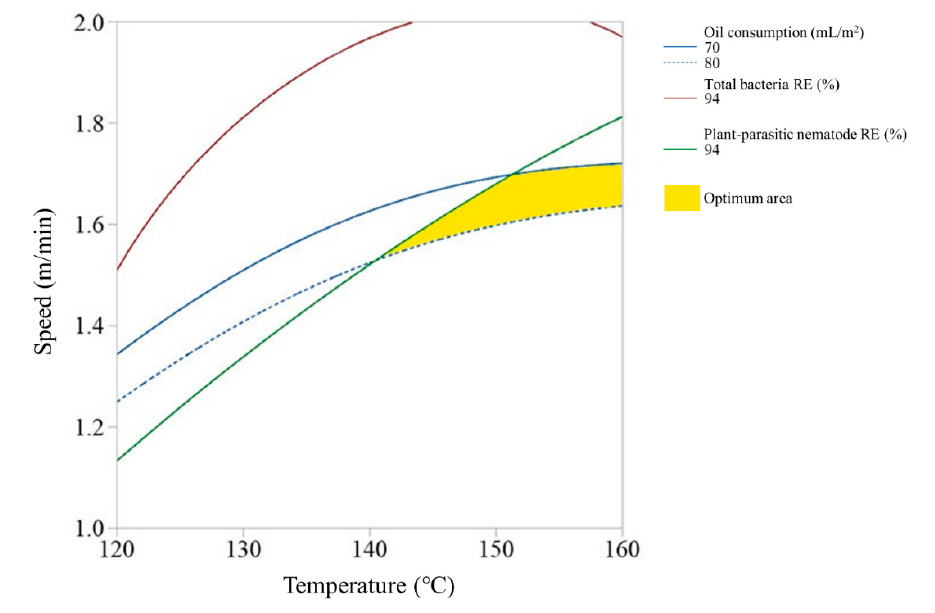
Figure 7. Overlay plot of the steam temperature and running speed on the response variables when the spray depth is 15 cm.